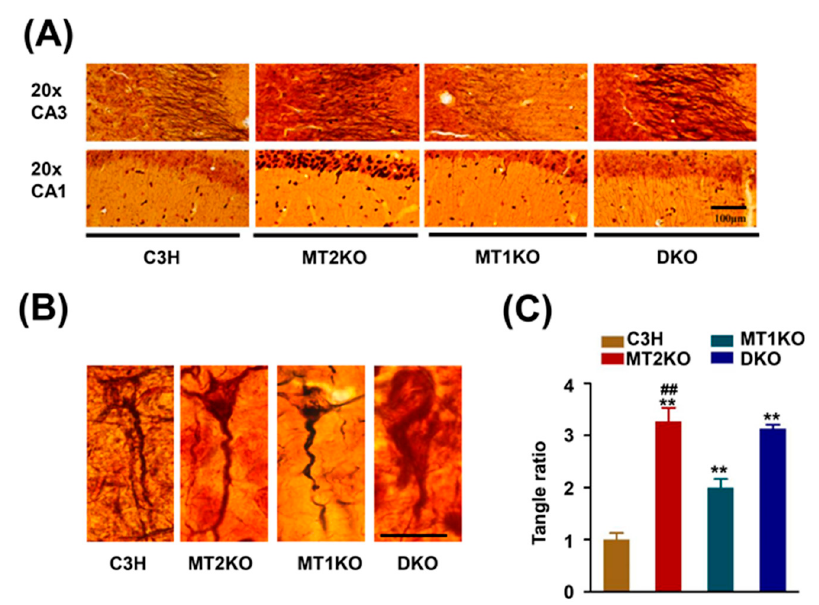
Figure 2. Bielschowsky silver staining. ( A ) Bielschowsky silver staining in hippocampus. ( B ) Bielschowsky silver staining for ghostlike neurofibrillary tangles in three transgenic mice. ( C ) Relative number for the total typical neuron in the four groups. Bar = 100 μ m. ** p < 0.01, compared with C3H. ## p < 0.01, compared with MT1KO mice. Data are presented as means ± SD.